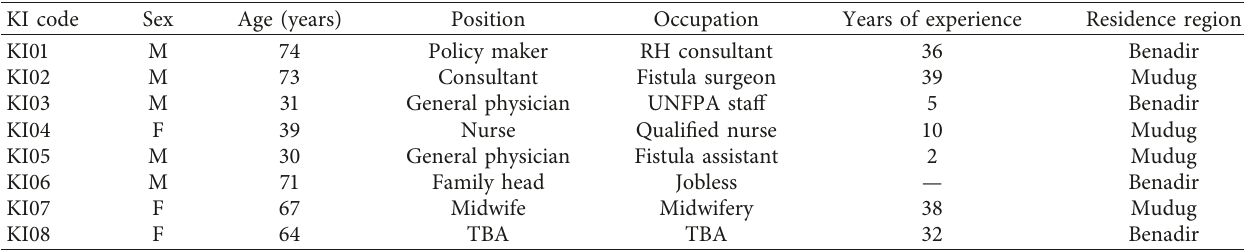
Table 3: Characteristics of key